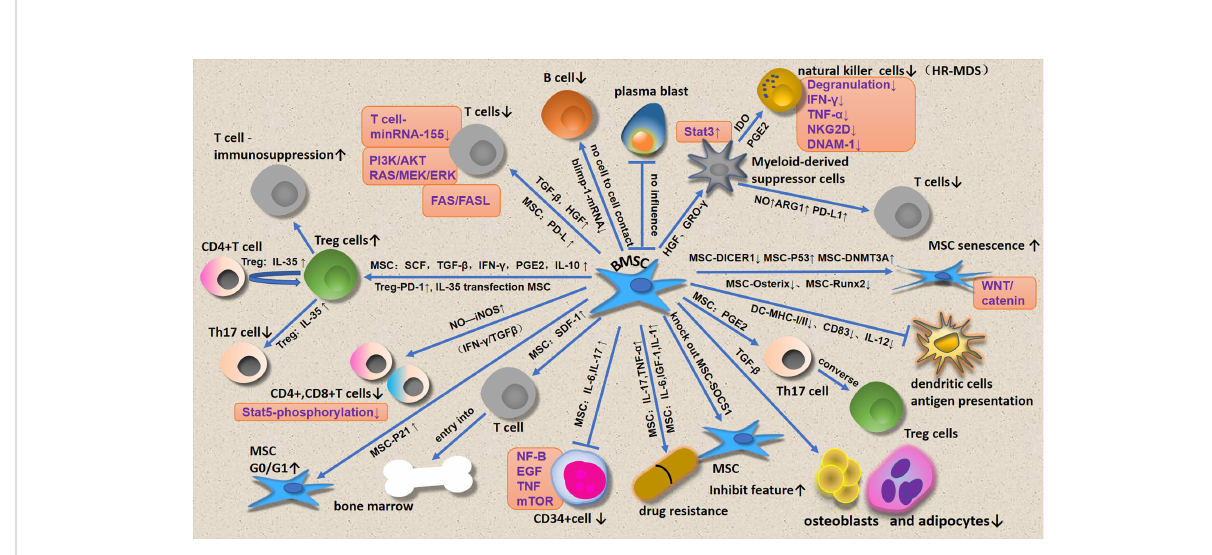
FIGURE 1 Effects of BMSCs on BM microenvironmental